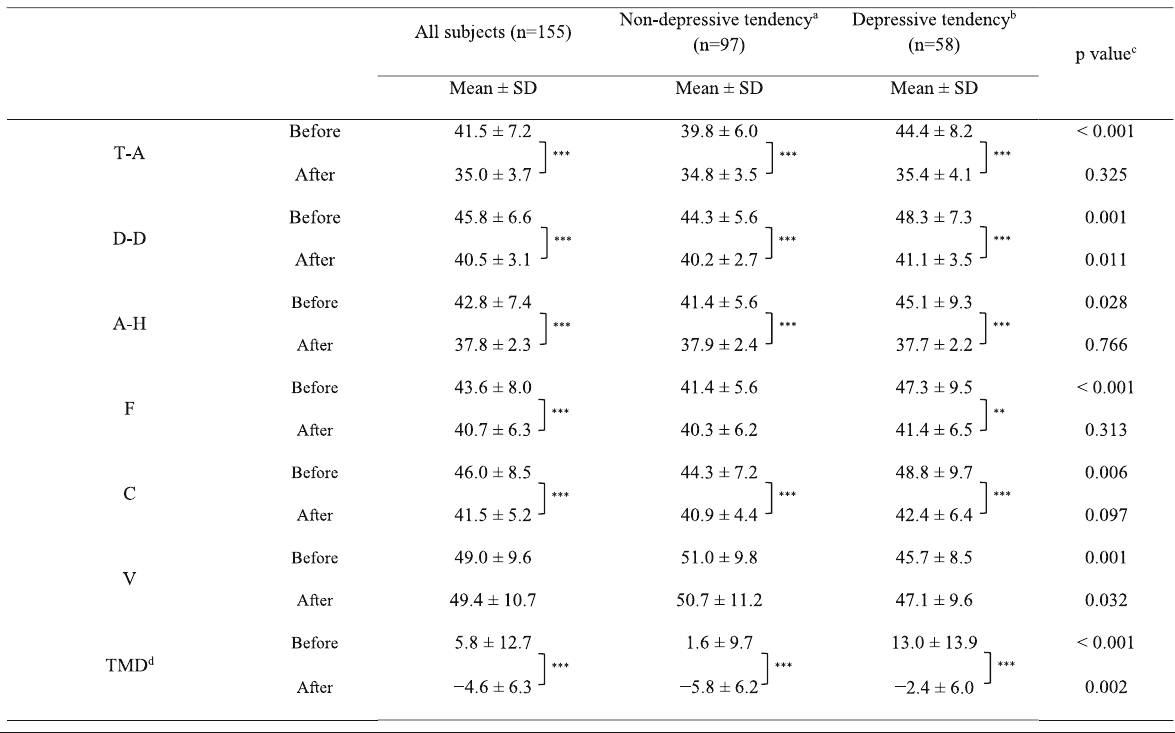
Table 3 Changes in POMS and TMD scores before and after Forest bathing in the subjects with and without depressive